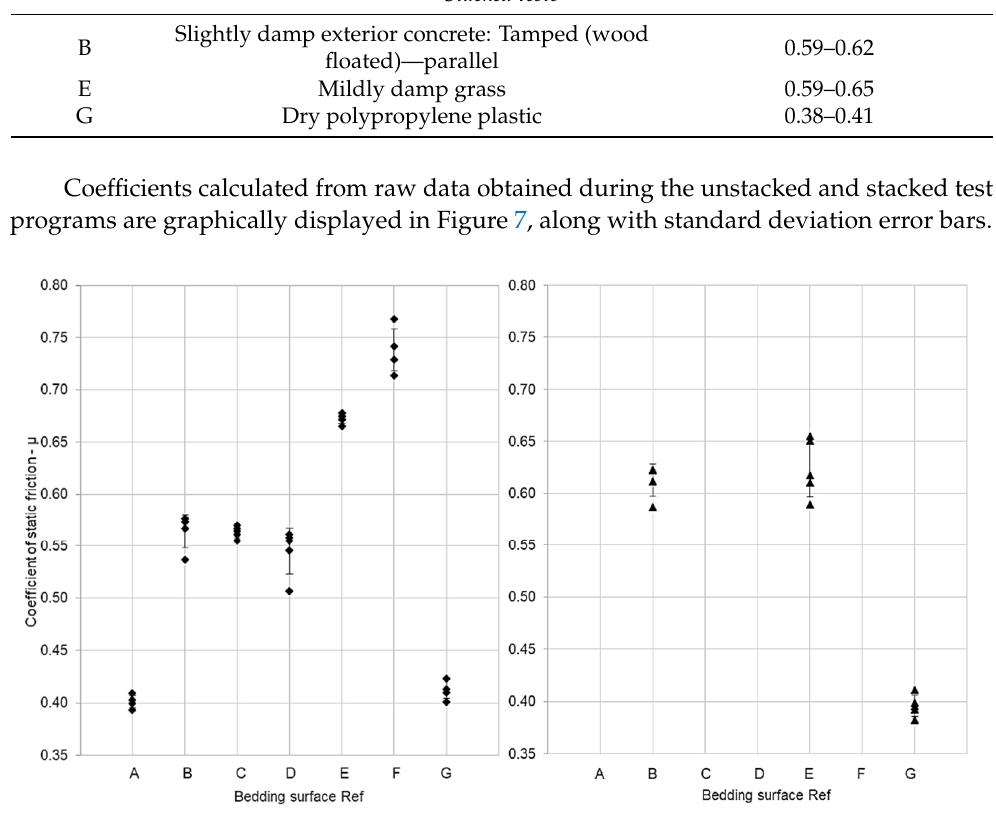
Figure 7. The standard deviation of calculated coefficients of static friction: unstacked tests ( left ); stacked tests ( right ).